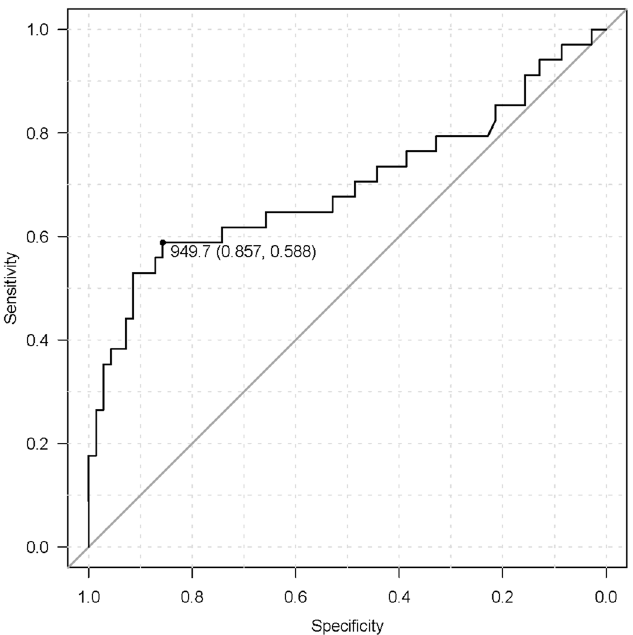
Figure 2. Receiver operating characteristics (ROC) analysis regarding the detection of KRAS -mutated ctDNA before chemotherapy in 22 patients considering all estimated points of ctDNA. ROC determined the cut-off value of CA19-9 at 949.7 U/mL to predict the presence of KRAS -mutated ctDNA in the blood during chemotherapy with a sensitivity and specificity of 58.8% and 85.7%, respectively. CA19-9 value ≥ 949.7 U/mL predicts the presence of KRAS -mutated ctDNA in the blood during chemotherapy with 58.8% sensitivity and 85.7%